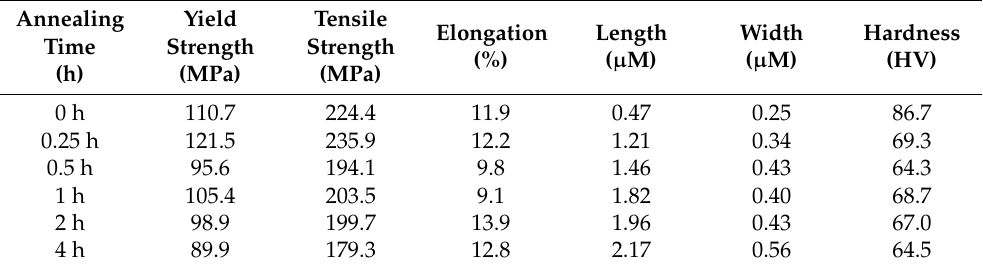
Table 1. The mechanical properties of the annealed Al-14.5Si alloys solidified under a 3000 g gravity field after